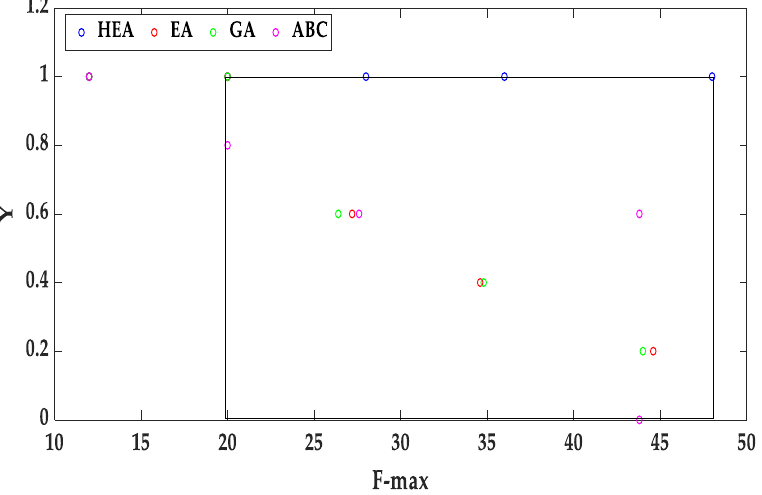
Figure 14. A trade-off plot of fitness max ( ) F and diversity ( ) for different DHNN.